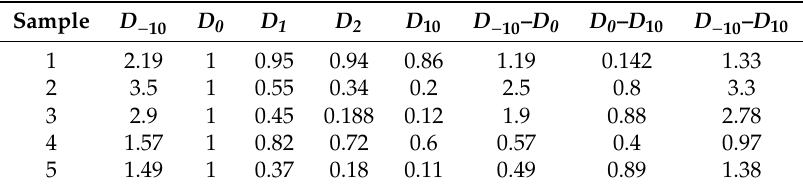
Table 3. The generalized dimensions of samples.